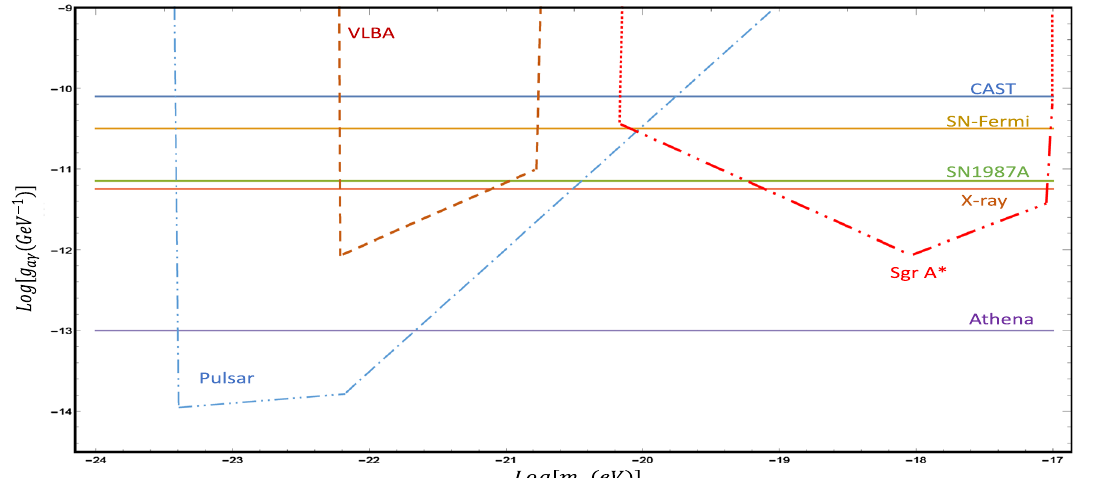
Fig. 3 Upper limits of the ALP-photon coupling g a γ for different ALPs mass m a . The ranges 10 − 14 (cid:2) g a γ ( GeV − 1 ) (cid:2) 10 − 10 and 10 − 24 (cid:2) m a ( eV ) (cid:2) 10 − 17 follow from the observations of the CAST experiment [20], the Fermi-LAT observation of a population of SNe